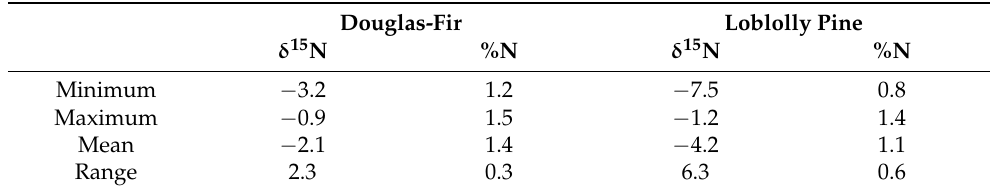
Table 2. Summary statistics of δ 15 N (‰) and %N in Douglas-fir and loblolly pine foliage collected during the growing season of 2012. Douglas-Fir Loblolly Pine